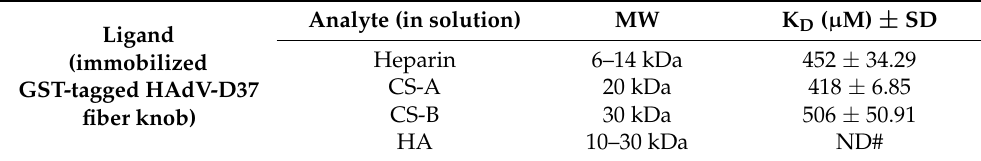
Table 1. Surface plasmon resonance (SPR) analysis of the interaction of HAdV-D37 fiber knob with different GAG polysaccharides.